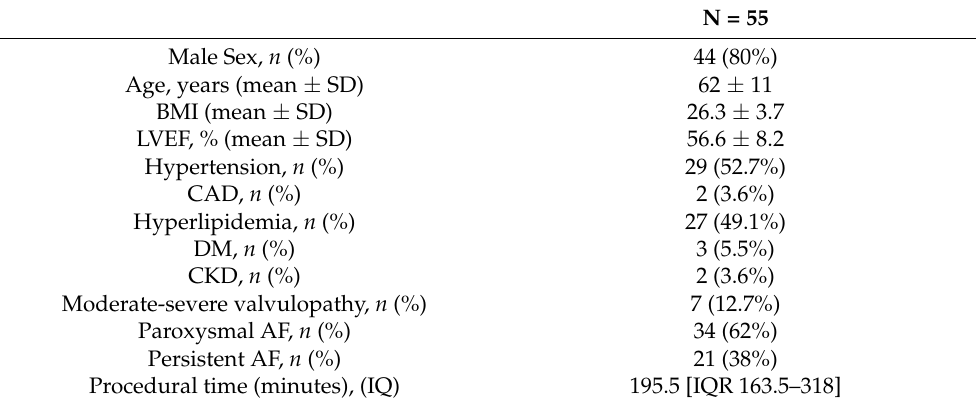
Table 1. Baseline patient characteristics and procedural